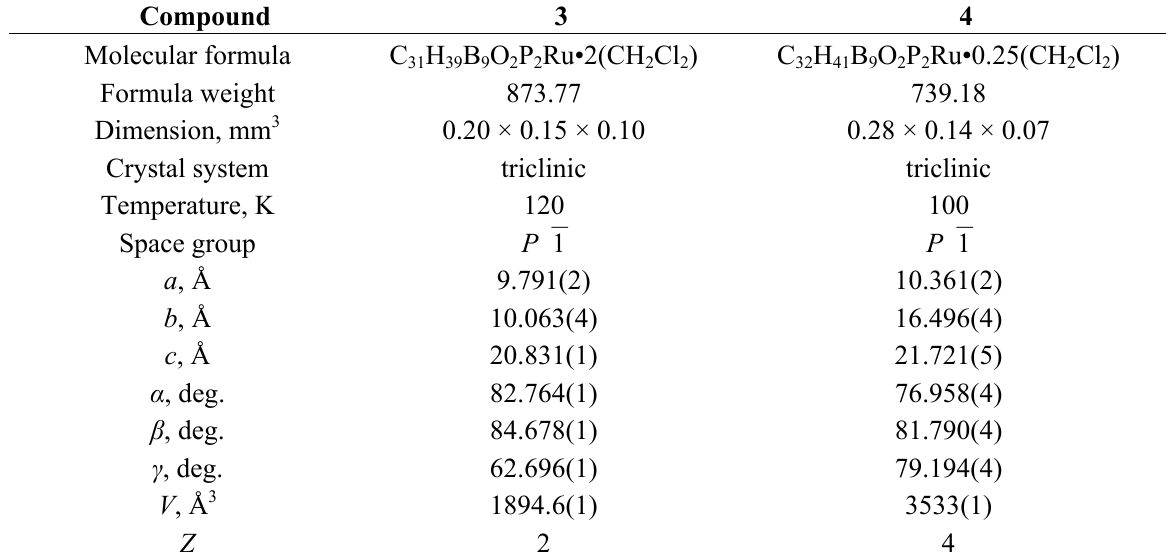
Table 2. Crystal data, data collection and structure refinement parameters for 3 and 4